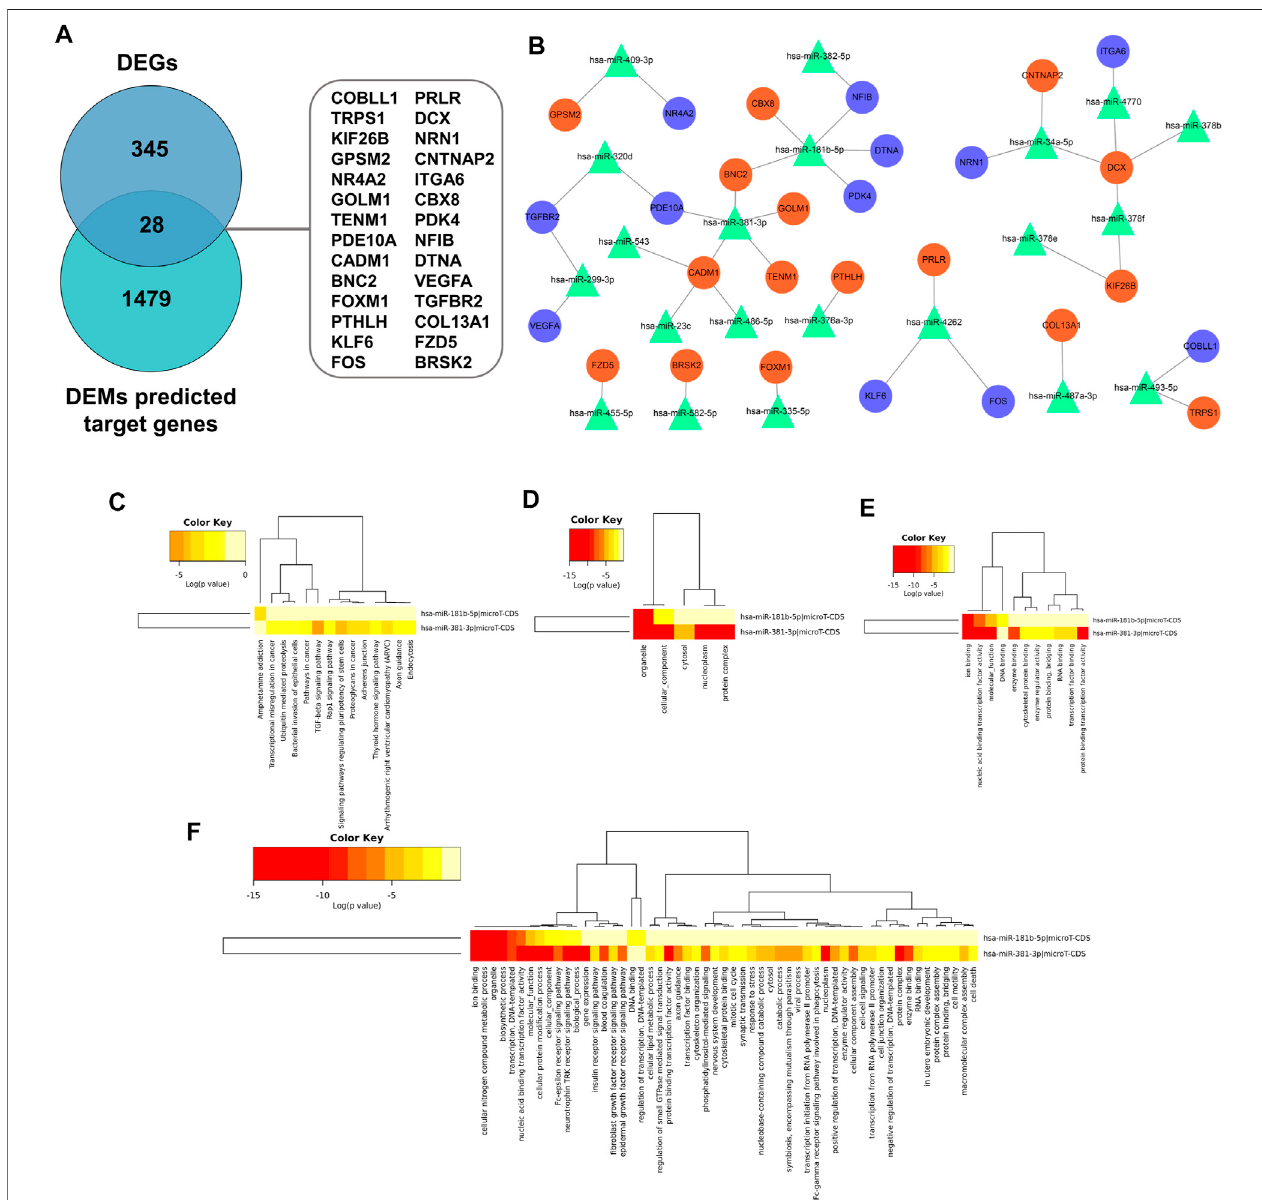
FIGURE 9 | (A) Screen of DETGs of DEMs. The intersection of DEMs and predicted target genes by miRwalk3.0. (B) The miRNA-mRNA regulatory network. Triangles, DEMs; Orange circles, upregulated DETGs; Purple circles, downregulated DETGs. Function annotation and KEGG analysis of hub DEMs. (C) KEGG pathways; (D) CC-terms; (E) MF-terms; (F)